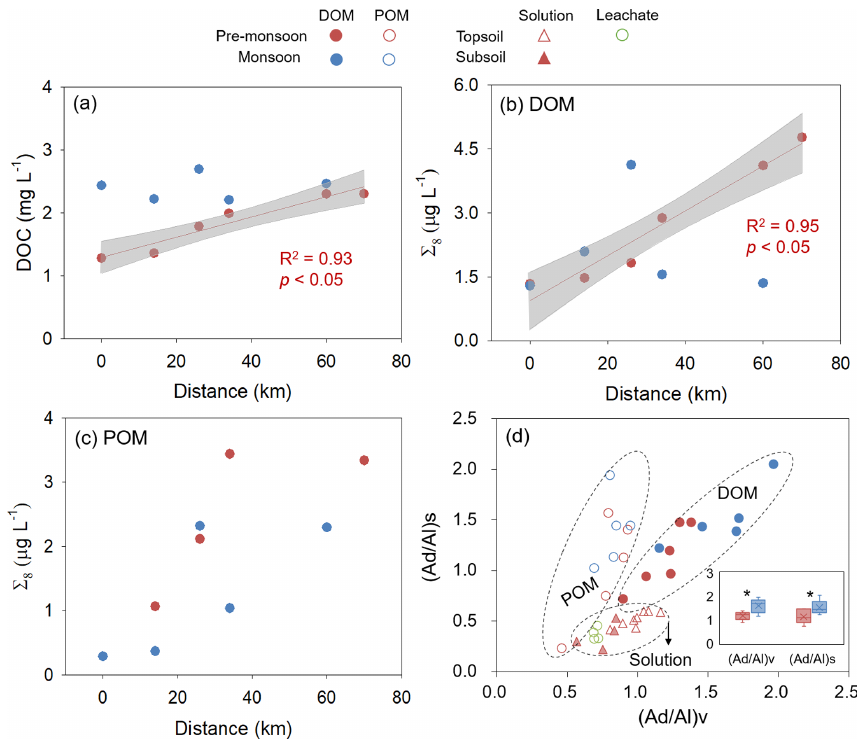
Figure 3. Variations in dissolved organic carbon (DOC) in Shaliu River water (a) , absolute concentration of lignin phenols ( (cid:54) 8 ) in riverine dissolved organic matter (DOM; b ) and particulate organic matter (POM; c ) during the pre-monsoon and monsoon seasons in 2015. The acid-to-aldehyde (Ad / Al) ratios of syringyl (S) and vanillyl (V) phenols in the riverine DOM, POM, soil solutions and leachates (d) . The abscissa in panels (a) , (b) and (c) mean the distance of sampling sites from SLH-0. The red lines in panels (a) and (b) correspond to the linear regression of data ( p < 0.05), and the grey shaded regions in panels (a) and (b) show 95% confidence intervals. The inserted box in (d) is the comparison of (Ad / Al ) V and (Ad / Al ) S ratios of dissolved lignin phenols between pre-monsoon and monsoon seasons, respectively, with asterisks indicating significant differences (independent sample t tests, n = 5, p < 0.05). The solid bar and cross in the inserted box mark the median and mean of each dataset, respectively. The upper and lower ends of the box denote percentiles 0.25 and 0.75,